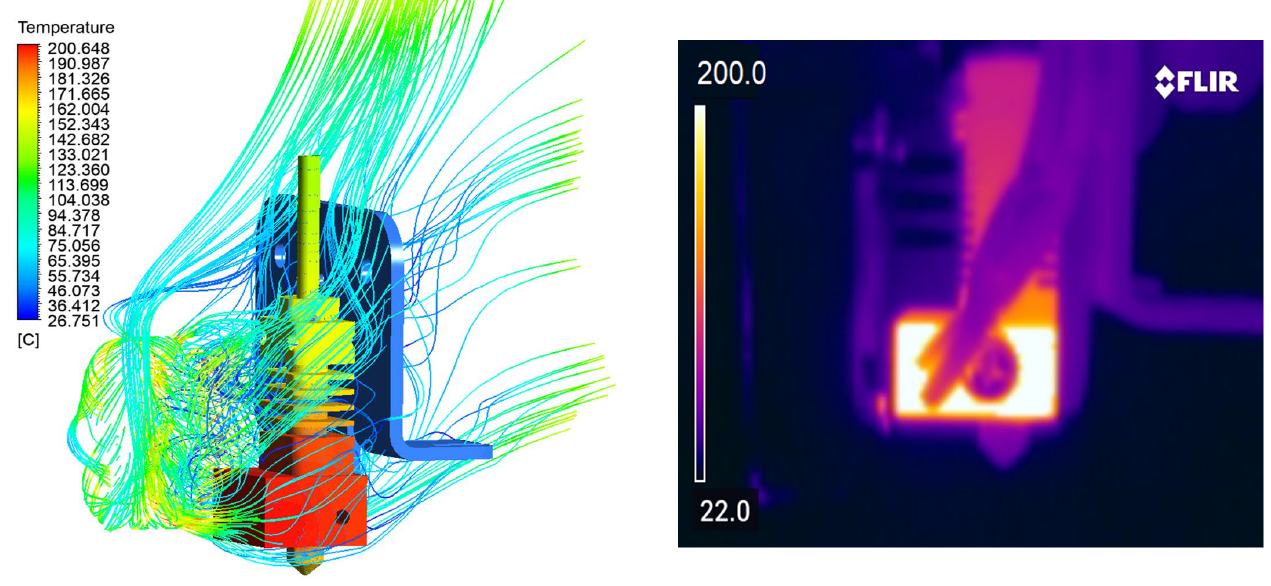
Figure 9. Simulation and experimental results for convective heat transfer. Left is the forced convec- tion simulation with both temperature contours and airflow streamlines around the extruder. Right is the thermal imaging camera result of the same extruder while printing.